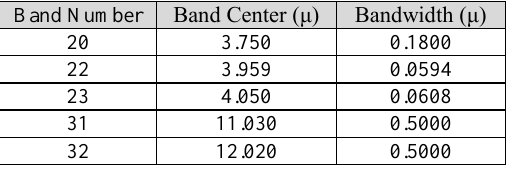
Table 1. Bands for MODIS Infrared SST Determination